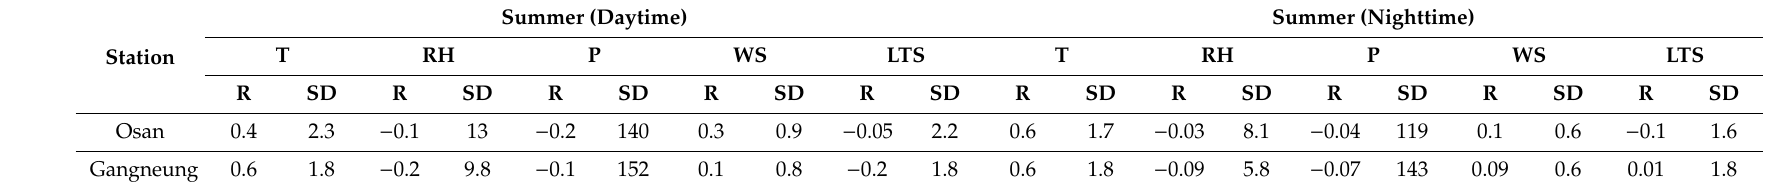
Table 3. Correlations between PBLH and meteorological parameters during summer.